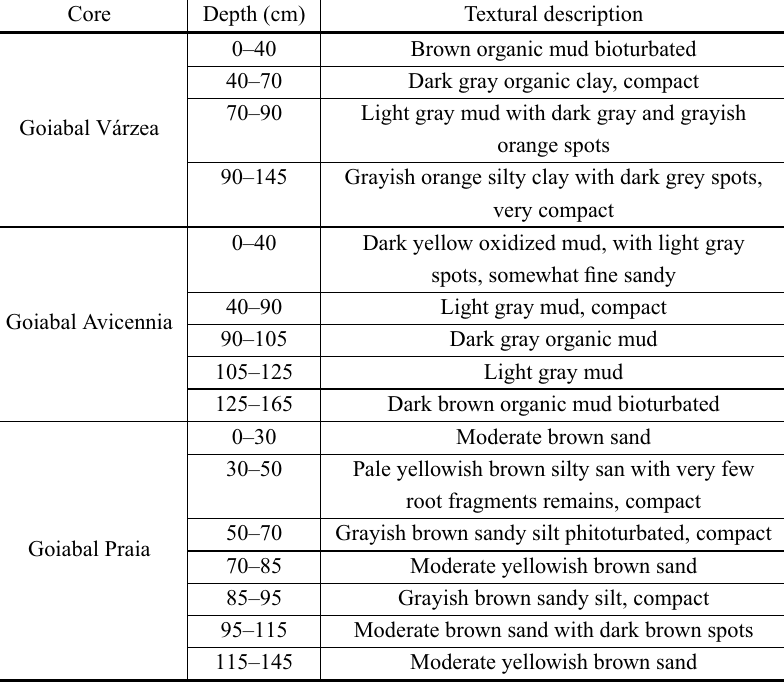
Textural description of the sediment